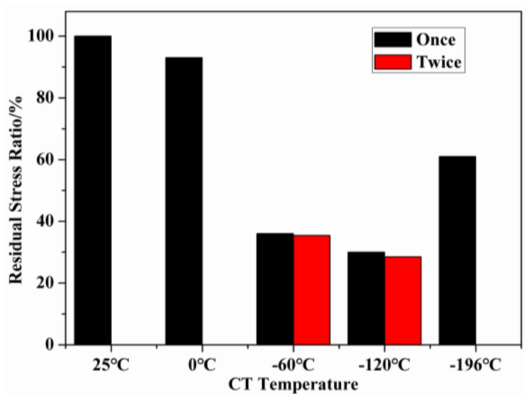
Figure 8. Residual stress ratio curves of 7075 alloy after different CT temperatures.